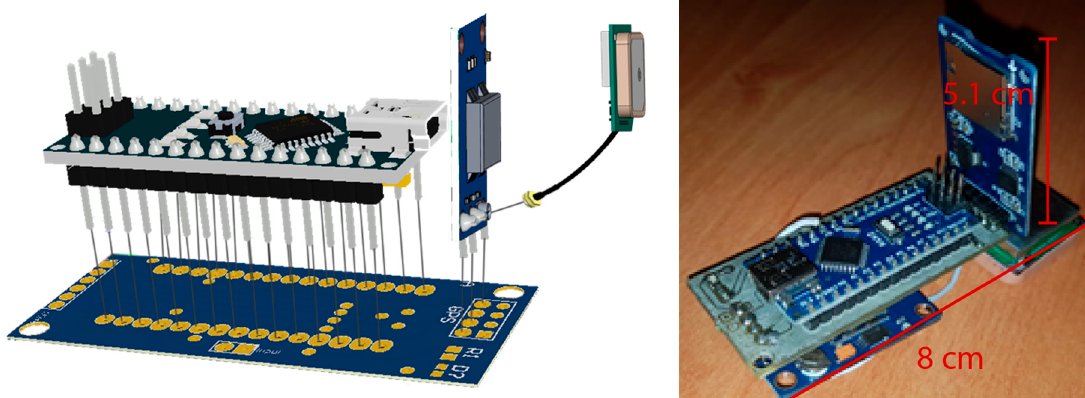
Figure 4. RiverCore mobile node components.